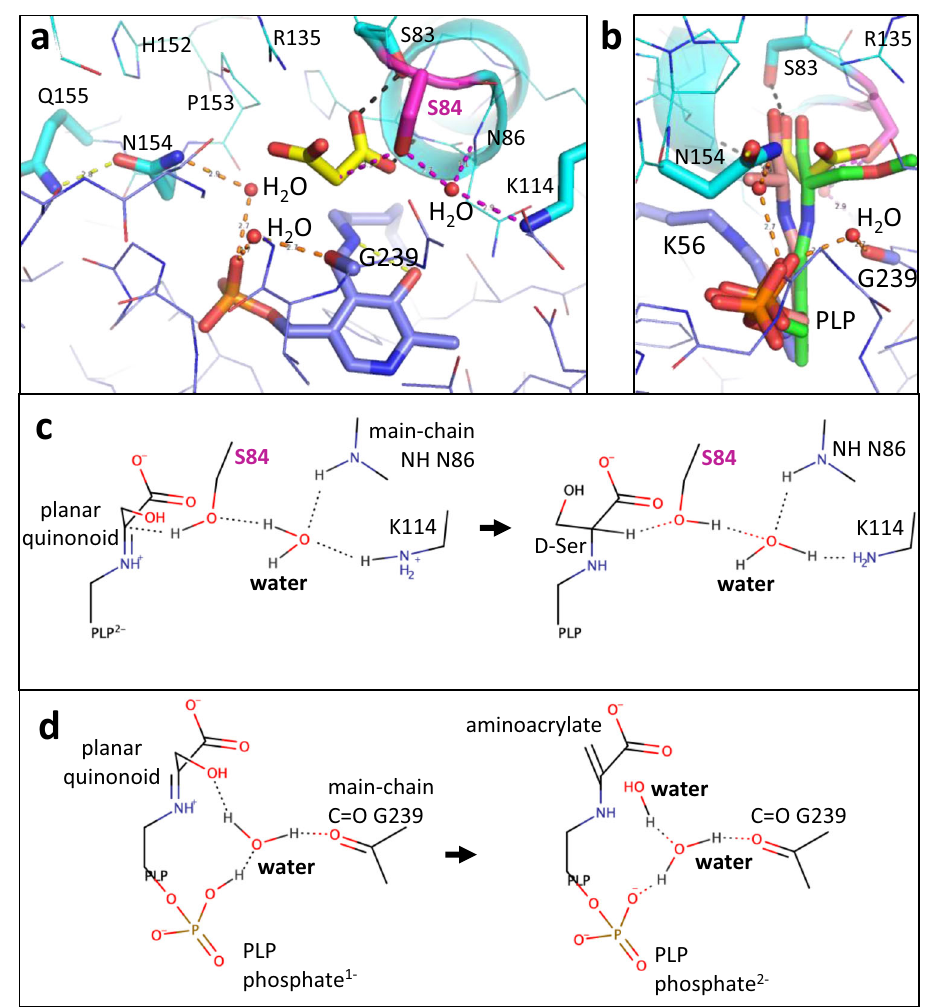
Fig. 9 Comparison of proposed mechanisms for racemisation and β -elimination. a View of the active site in the malonate (yellow carbons) hSR complex (6ZSP). Three water molecules are shown (small red spheres). b Orthogonal view with D-alanyl-PLP (pink carbons) and methylserine PLP (green carbons) superposed as in Fig. 8. c A water molecule between Lys 114 and Ser 84 has been proposed to facilitate protonation of the substrate to give D-serine 36 . d The dehydration of the substrate has been proposed to be facilitated by the phosphate group of PLP 79 . The mechanism shown is modi fi ed to include a water holo SR (6SLH) which was crystallised against reservoir/precipitate of 100 mM Bis- Tris pH 6.5, 15% PEG 3350, 250 mM MgCl 2 33 . ATP was present in the protein delivery buffer at 1.25-fold times the protein subunit concentration. Crystal soaking, harvesting, mounting, and data collections were performed at the Diamond Light Source XChem facilities and beamline I04-1 through the XChem work fl ow 50,59 . During preliminary crystal characterisation holo crystals were observed to tolerate concentrations of up to 40% DMSO. The full compound screen was performed on 600 crystals which were each soaked with 150 mM fragment compound (30% v/v of 500 mM stocks in DMSO) for ≥ 1.5h before crystals were harvested and mounted on the fast microscope crystal mounting system 60 . The fragments screened were obtained from the Diamond-SGC-iNext Poised (DSiP) XChem library.